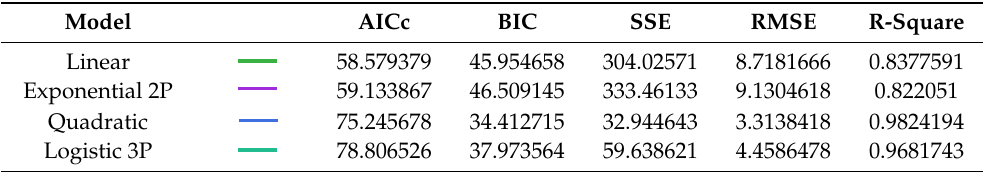
Table 4. Comparison table of the model for analyzing the dependence of the number of holes drilled up to the moment of tool damage and speed.